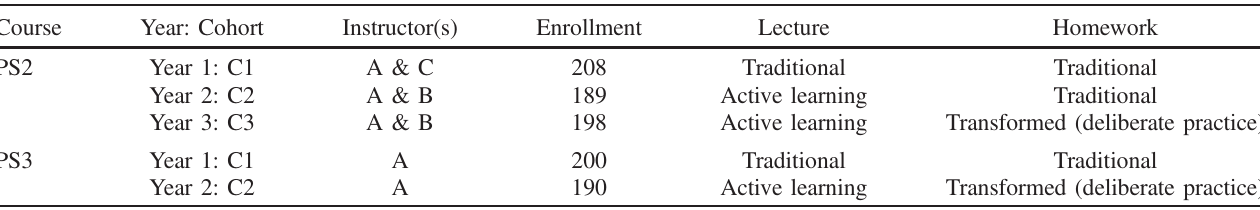
TABLE II. Pedagogical style in the lecture and homework portions for both courses, across three cohorts in three consecutive years.